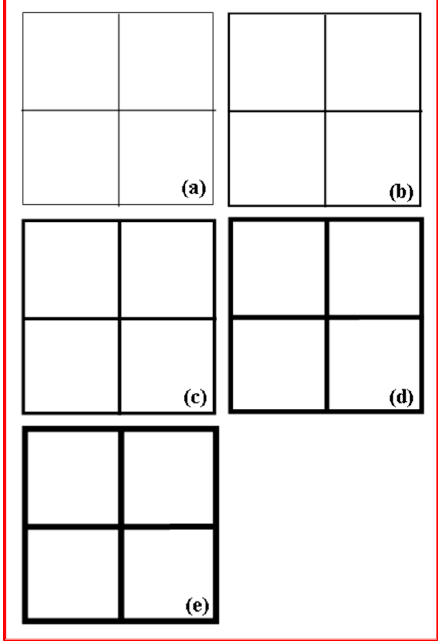
Figure 3. A set of antennas with different diameters of the wire in which the gross area was 72 × 72 cm 2 and the area of the gap was 24 × 24 cm 2 . The wire diameters were ( a ) 0.5 mm, ( b ) 1.2 mm, ( c ) 2.4 mm, ( d ) 2.6 mm, and ( e ) 3.0 mm.